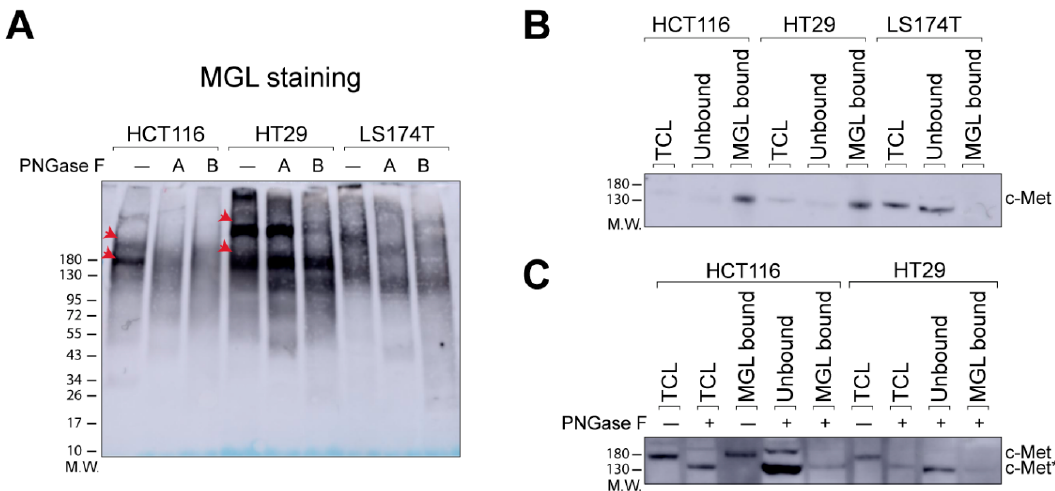
Figure 1. Release of N -glycans reduces the MGL-binding of proteins from CRC cell lines. ( A ) MGL pull-downs were performed without ( − ) or with PNGase F treatment (A and B) and captured proteins were subsequently analyzed by MGL-lectin blot. PNGase F treatment was performed either After (A) or Before (B) performing the MGL pull-down. The lectin blot is a representative of 3 biological replicates (see Figure S1). Red arrows indicate major stained bands. ( B ) MGL-binding of c-Met in HCT116, HT29, and LS174T cells. MGL pull-downs were performed and bound and unbound proteins were analyzed by western blot using a c-Met antibody. TCL: total cell lysate. ( C ) Influence of PNGase F treatment on the binding of c-Met to MGL in HCT116 and HT29 cells. MGL pull-downs were performed with or without prior treatment of the total cell lysate (TCL) with PNGase F. Samples were analyzed by western blot using a c-Met antibody. c-Met* represents the protein with released N -glycans. M.W.: Molecular weight.